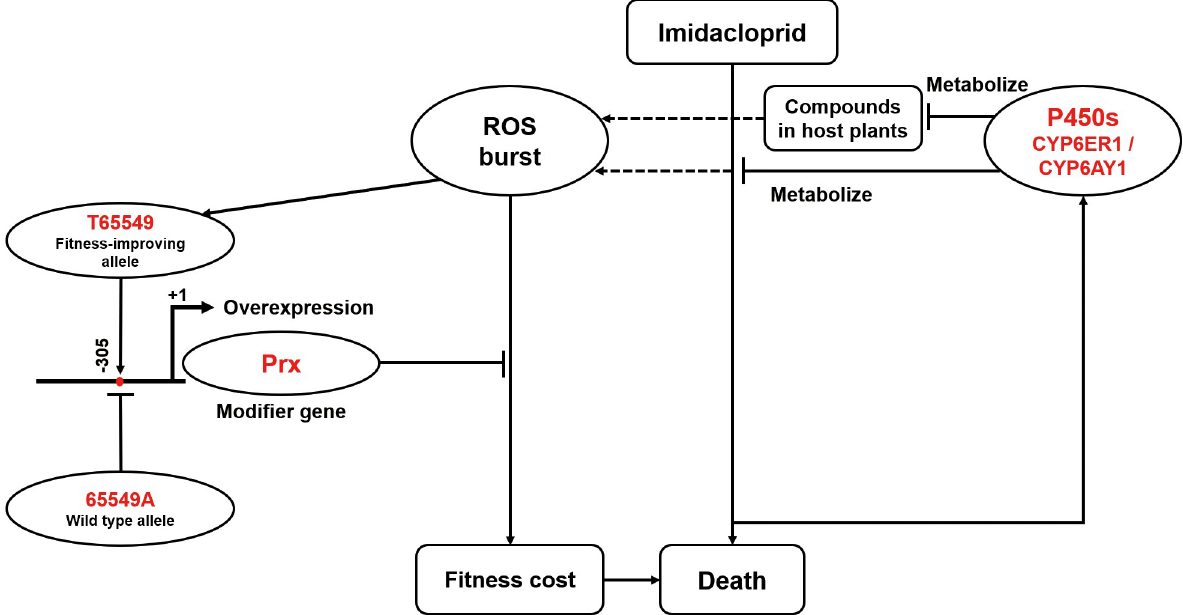
Fig 6. A working model for the sequential evolution of the overexpression alleles of P450s and NlPrx as well as their contributions to resistance of N . lugens to imidacloprid. ! , stimulation; ⟞ , inhibition; Prx, peroxiredoxin; ROS, reactive oxygen species.